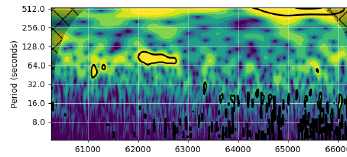
Figure 15. The wavelet power spectrum of residual SNR time series for station KBG1 ( left ) as depicted in Figure 14a with light green solid line and for station KBG2 ( right ) as depicted in Figure 14c with a light red solid line as observed for KBG1 and KBG2 on 1 March 2021 (DoY 60), as the satellite GPS PRN27 ascends, subtending the angles between 255 and 275 ◦ in azimuth. The Morlet wavelet is used to create a wavelet spectrum. The left axis is the period in seconds that corresponds to wavelet scales with base 2. The horizontal axes represent time (seconds). The representations of the Morlet wavelet spectrum show a significant power for KBG2 for the periods 30–64 and 64–128 s, spanning approximately 100 and 850 s, respectively. However, for the station KBG1, only a short-lived power is observed for the period 60–100 s. The thick contour encloses areas of higher than 95% confidence. The cross-hatched portions represent the cone of influence, where the edge effects become